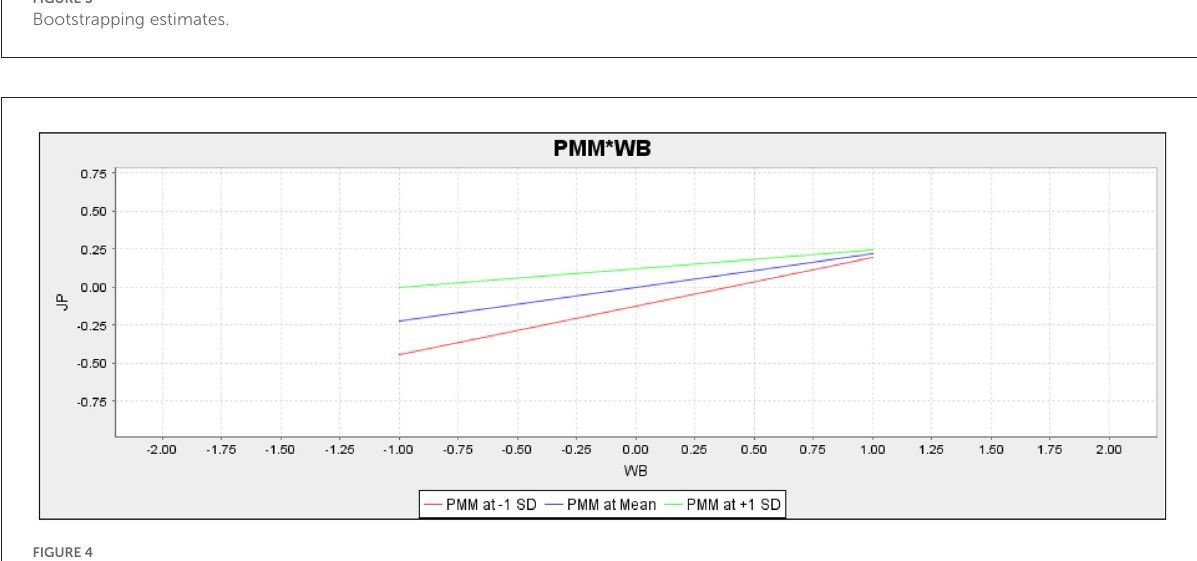
FIGURE4 Moderation slope of PMM *